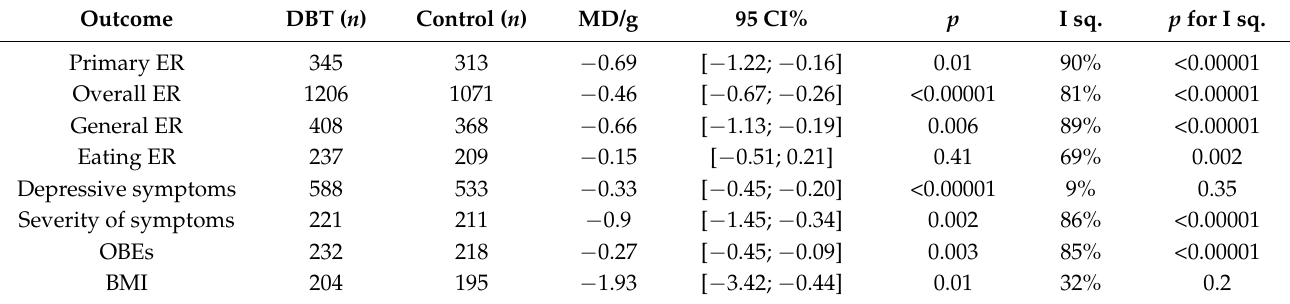
Table A1. Overall analysis results—non